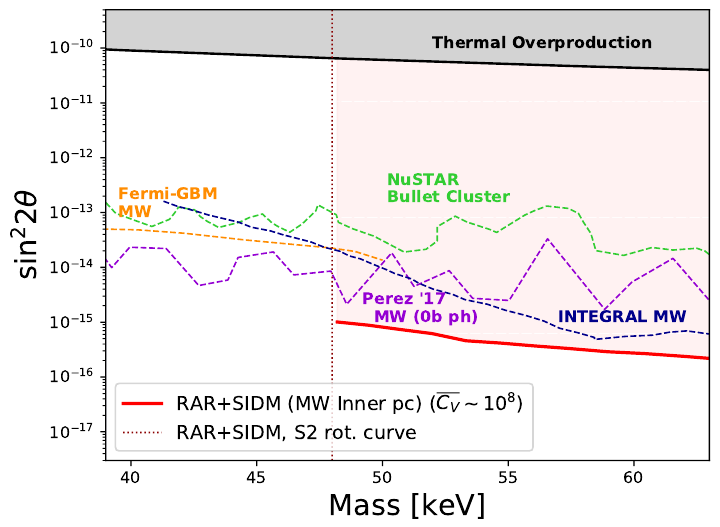
Figure 12. Sterile neutrino parameter space limits obtained for galactic center observations using the AMRR profiles (continuous red line) when assuming DM production due to self-interactions through a massive vector field mediator. The light-red-shaded region above the continuous red line corresponds to the AMRR limits given by X-ray bounds (i.e., indirect detection analysis), while the vertical shaded region below 48 keV indicates the smallest DM mass compatible with S-cluster stars’ rotation curve data. The upper shaded region corresponds to production mechanism bounds: non-resonant production under no lepton asymmetry. Other dotted lines refer to several X-ray bounds for different DM halo profiles, including 0-bounce photon analysis. Reprinted from [80], Copyright (2020), with permission from